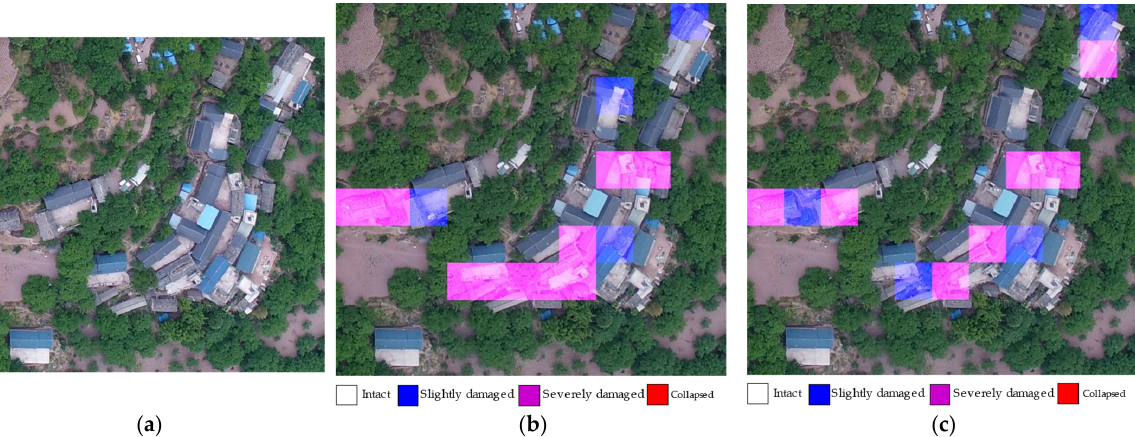
Figure 8. Example of assessment results of building damage in the Yangbi dataset: ( a ) original image; ( b ) EBDC-Net assessment results; ( c ) visual interpretation results .